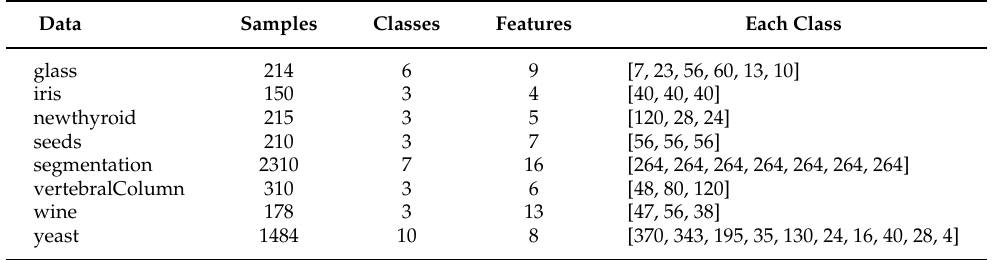
Table 5. Information about the multi-class data